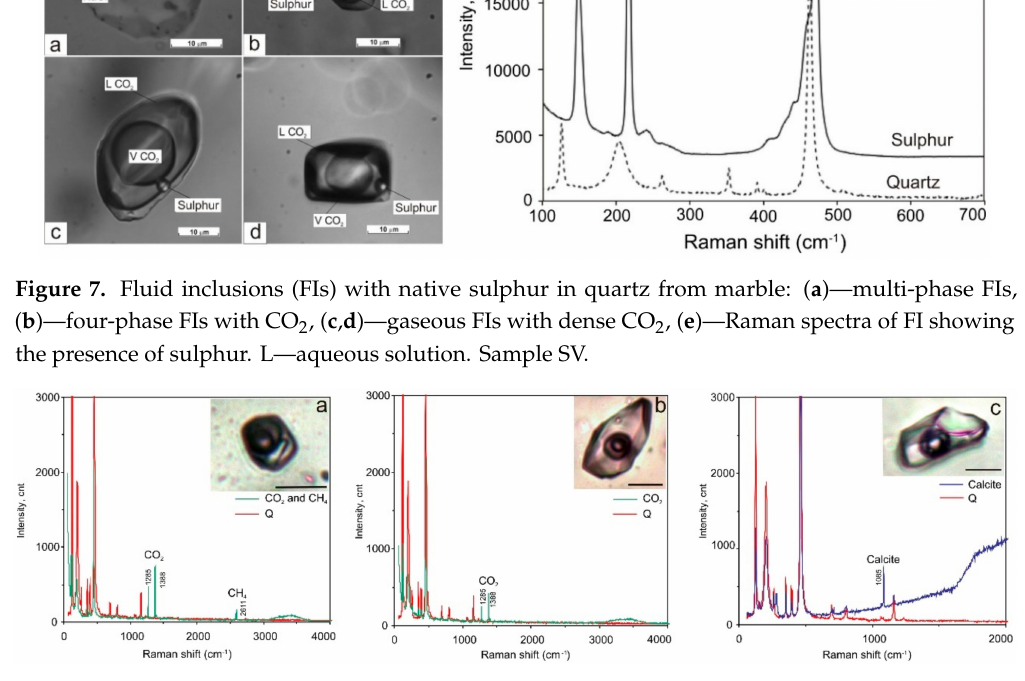
Figure 8. Selected laser Raman spectra of fluid inclusions showing the presence of CO 2 and CH 4 ( a ) and CO 2 ( b ) in gaseous phase of FIs as well as the presence of calcite as a solid phase ( c ). Sample 38-3a. Scale bar is 10 µ m. Q—quartz. Table 3. Gas species in the vapour phase of inclusions according to Raman spectroscopy (mol